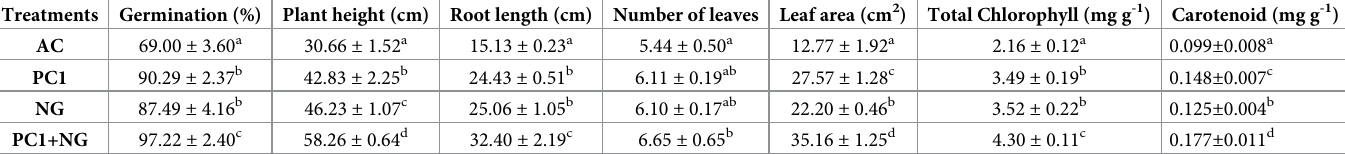
Means in each column followed by the same letter were not significantly different (P � 0.05) as determined by one-way ANOVA and Duncan’s Multiple Range Test (DMRT). Values were the means of three replications ±